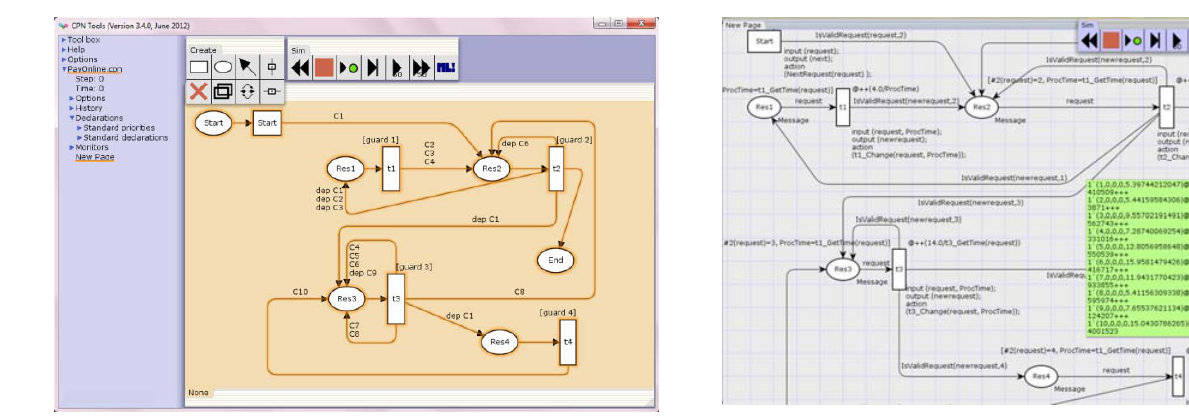
Fig. 10. The colored Petri net of the online shopping system